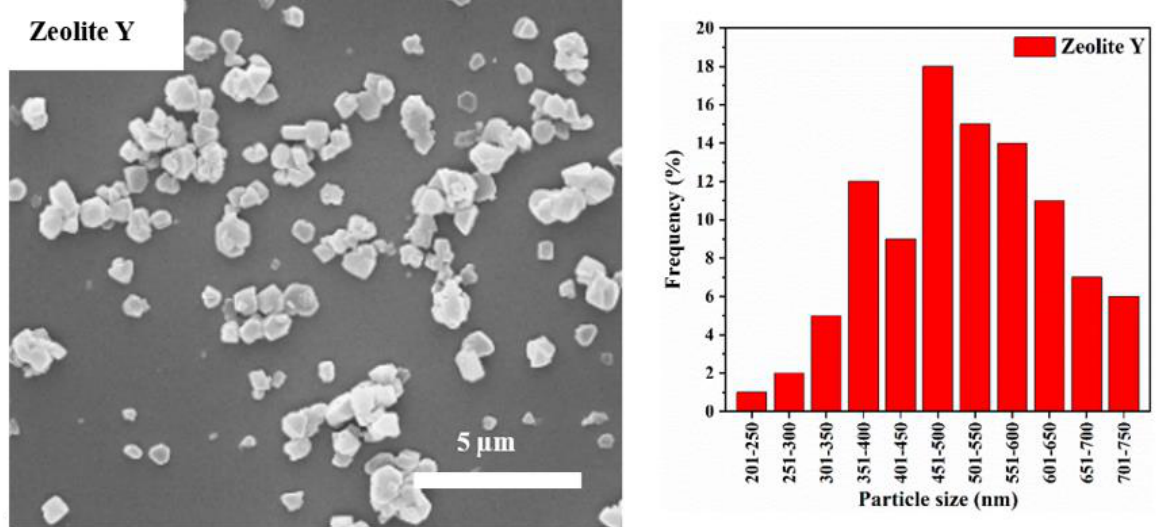
Figure 2. SEM images (left) and particle size distribution (right) of commercial zeolite Y particles.